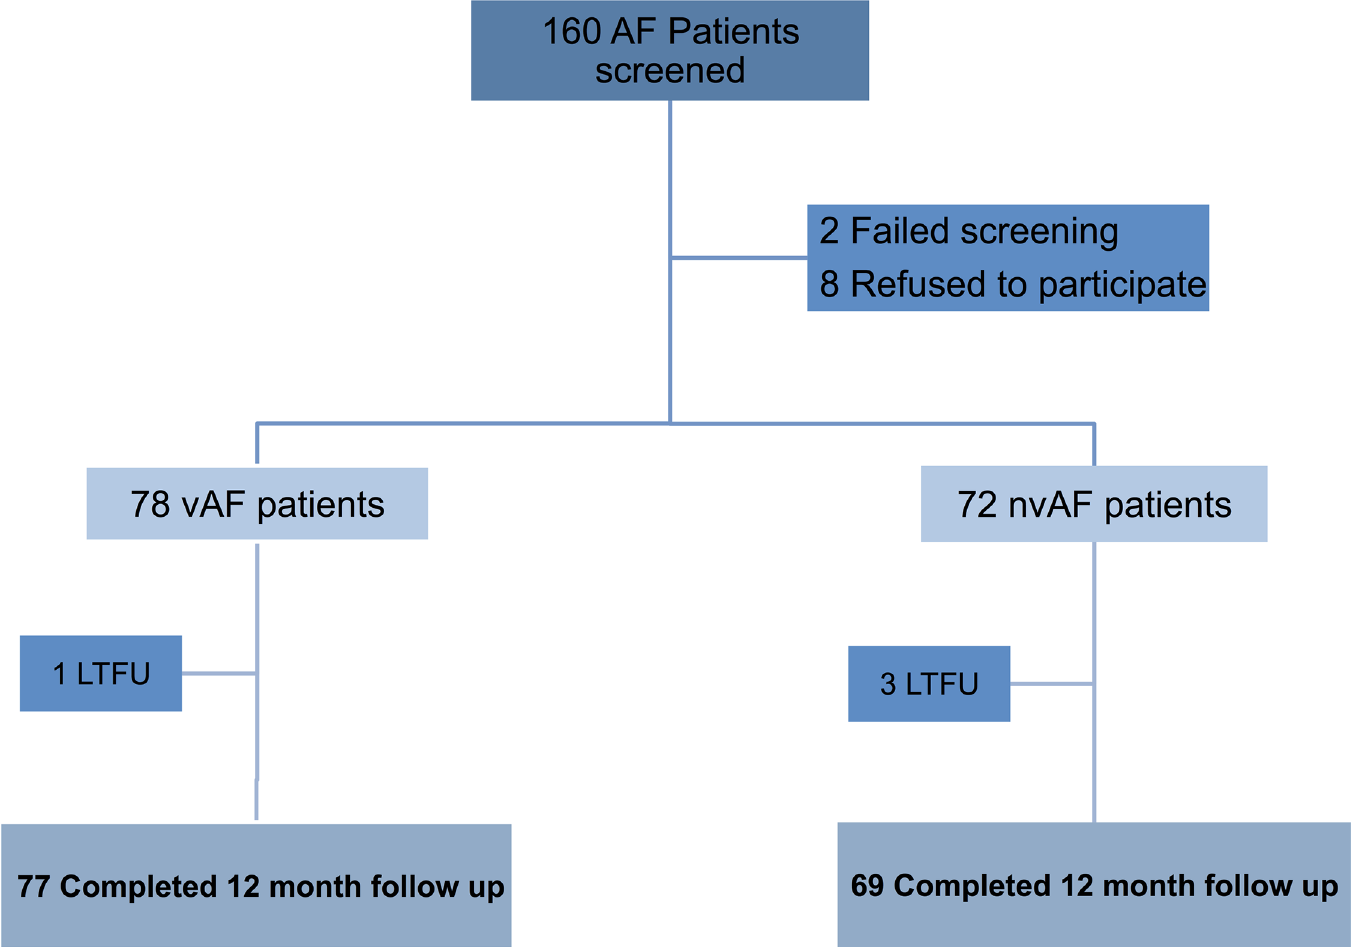
Fig 1. Flow diagram of enrollment and12-months follow-up. Legend.AF = atrial fibrillation,LTFU = lost to follow up.